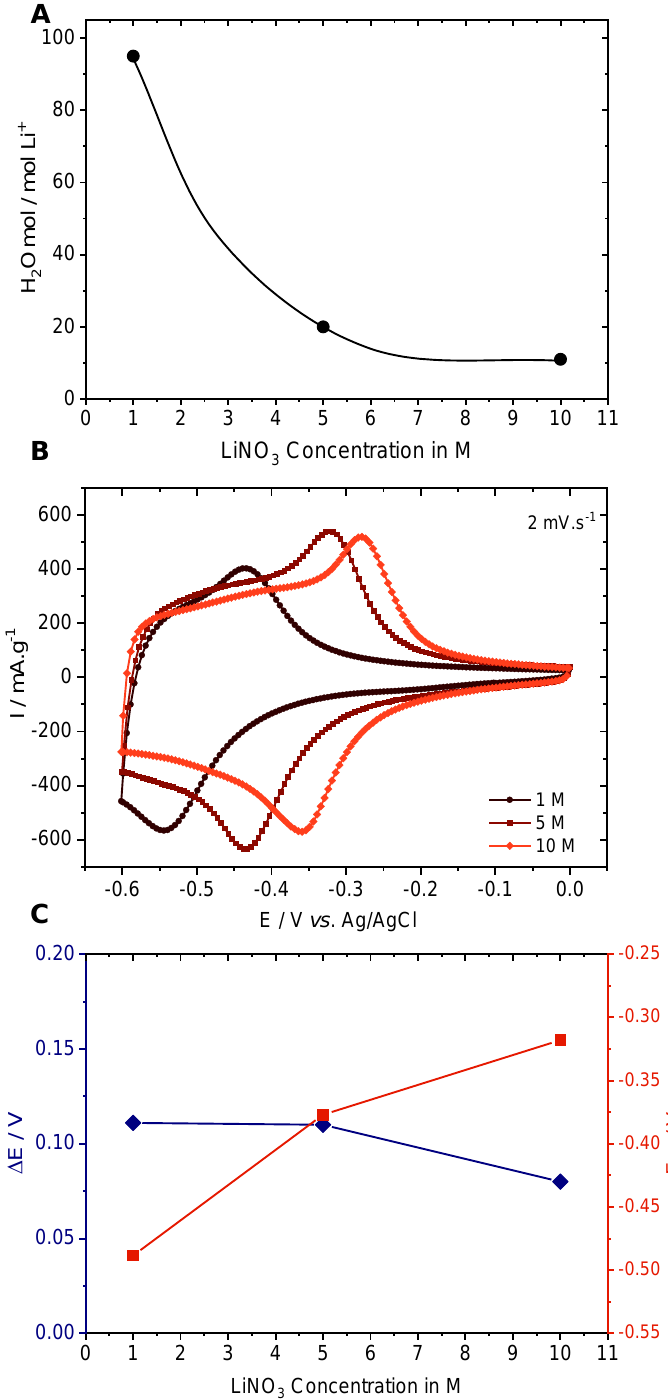
Figure 8. ( A ) Ratio of moles of H 2 O to moles of Li + cations vs. electrolyte concentration. ( B ) Li-HTB cyclic voltammograms in 1, 5, and 10 M aqueous LiNO 3 and ( C ) ∆ E and E 1/2 vs. electrolyte concentration. The electrochemical response as a function of the salt concentration is shown